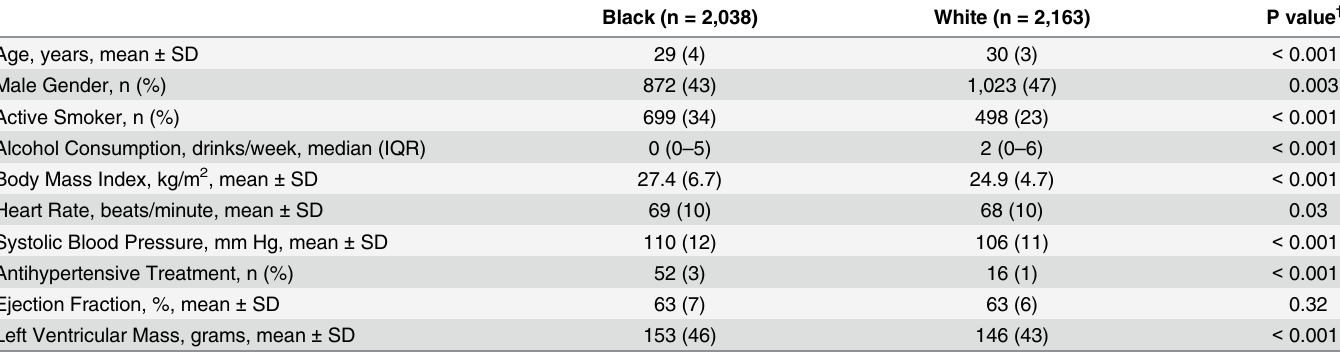
Table 1. Baseline Characteristics of CARDIA Participants by Race * .